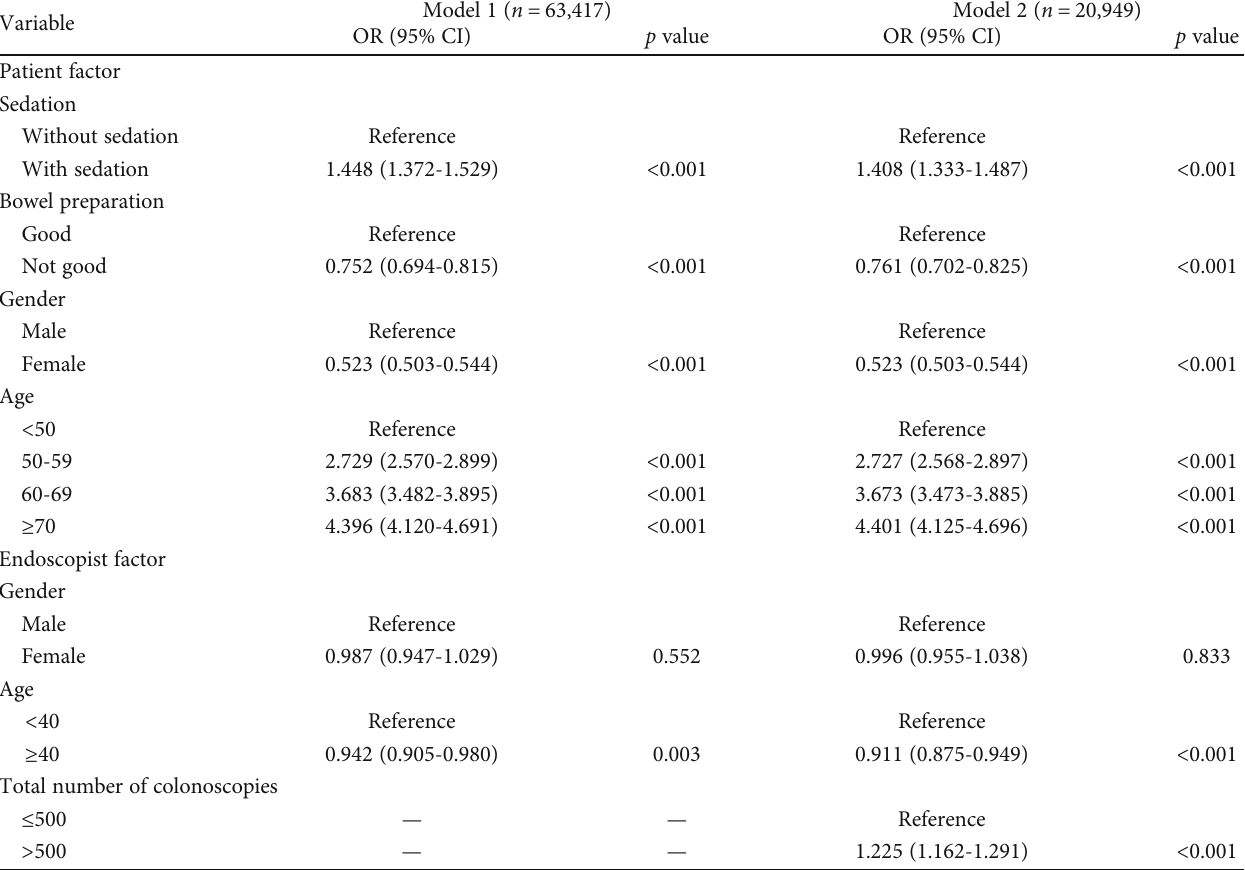
Table 2: Logistic regression analysis of risk factors for adenoma detection